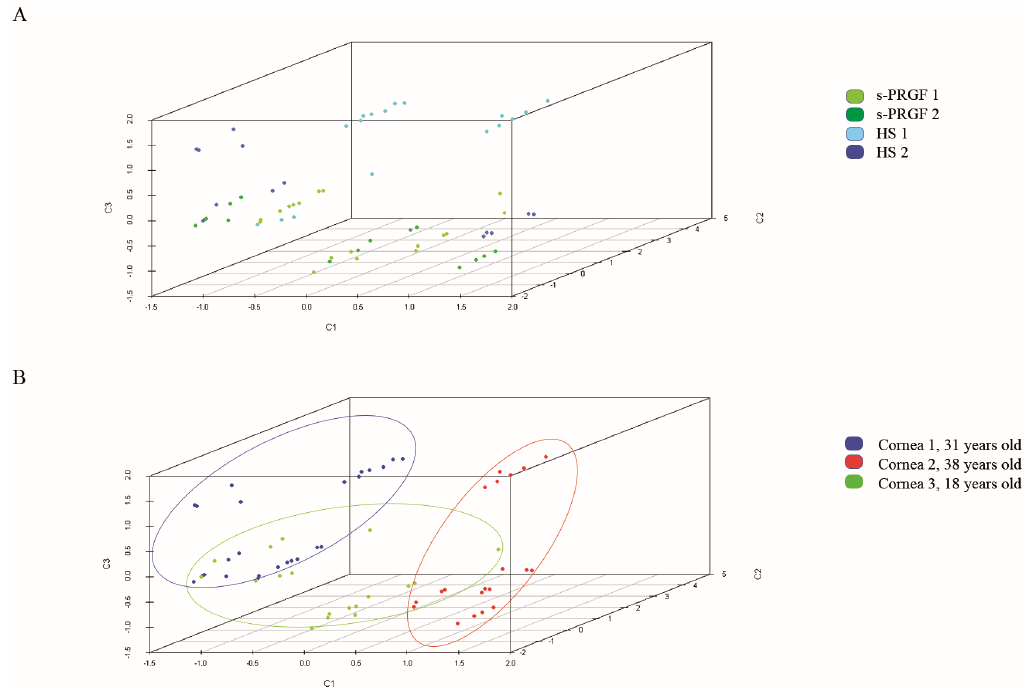
Figure 5. Figure 5. Representation of samples treated with human sera in three components obtained by PCA analysis. Colors indicate ( A ) treatments; ( B ) group of cornea-HAM (human amniotic membrane). Samples were classified mainly by cornea-HAM and not by